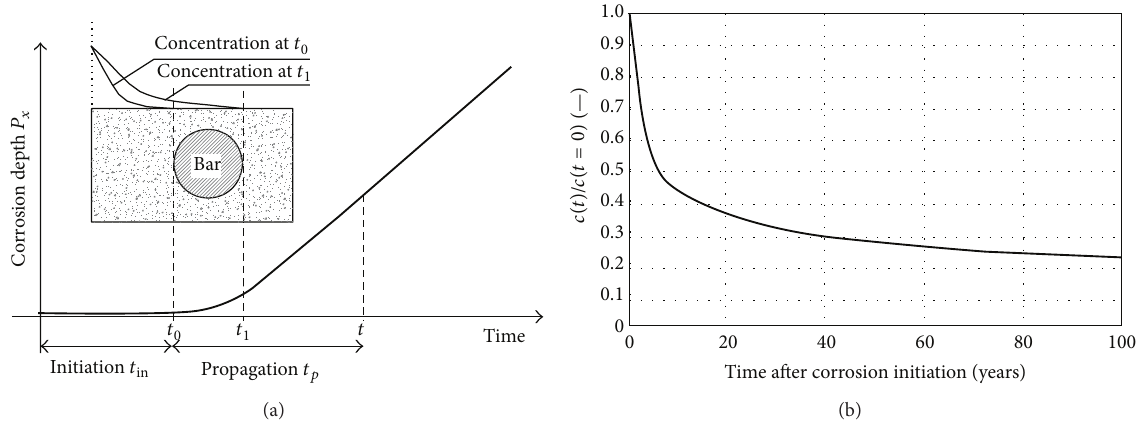
Figure 16: (a) Corrosion process over time. (b) Development of corrosion rate over time.